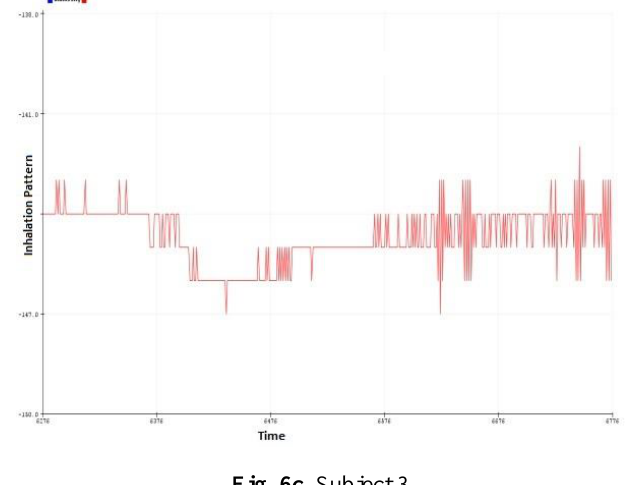
Fig. 5 . Variation in breath or inhalation level of hypertensive patients with respect to time, which ranges from -144 liters to -157 liters